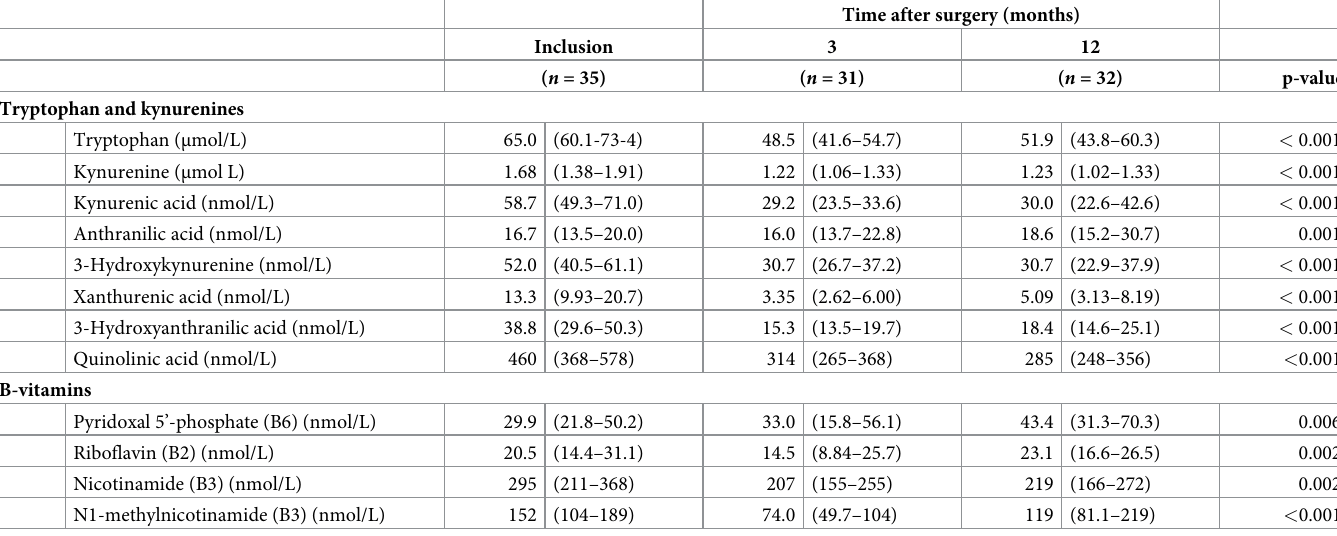
Levels of PLP were not significantly changed at three months after surgery, but an increase was observed after one year. The vitamin B3 form nicotinamide as well as the catabolite N 1 - methylnicotinamide decreased three month after surgery, though the latter increased between three months and one year. Levels of N 1 -methylnicotinamide at one year post surgery did not Table 4. Circulating levels of tryptophan, kynurenines and B vitamins before and after bariatric surgery. Time after surgery